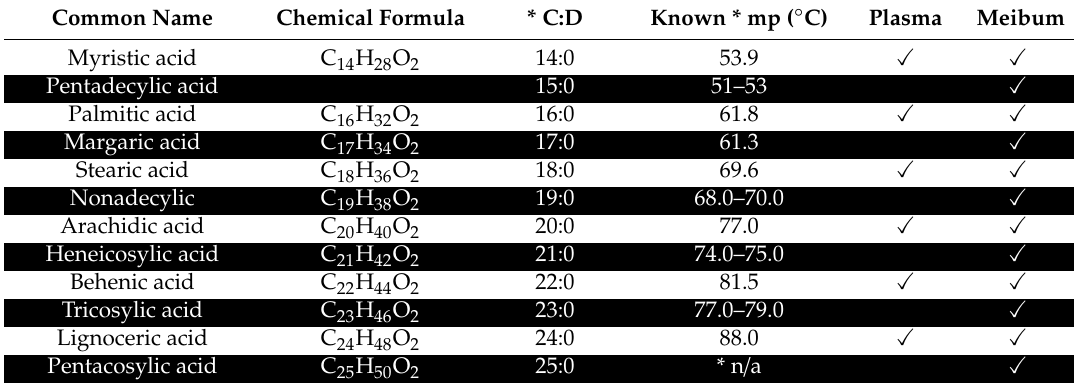
Table 1. List of various fatty acid moieties of the lipid species detected in plasma and meibum. Common